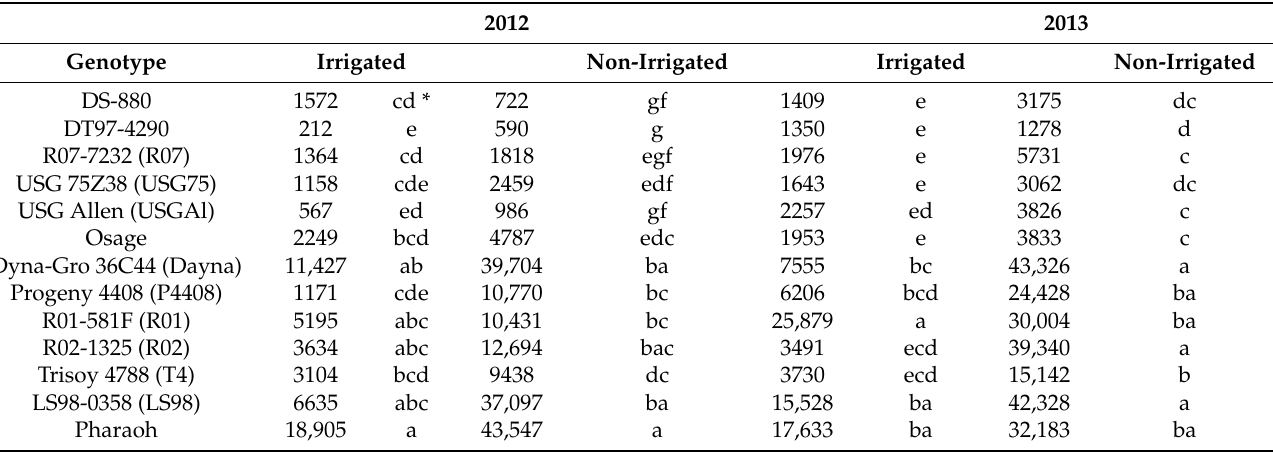
Table 2. Macrophomina phaseolina infection levels (colony forming units, CFU/g) determined at growth stage R7 under irrigated and non-irrigated conditions for the thirteen soybean genotypes in 2012 and 2013. Table was modified from Mengistu et al. (2018).